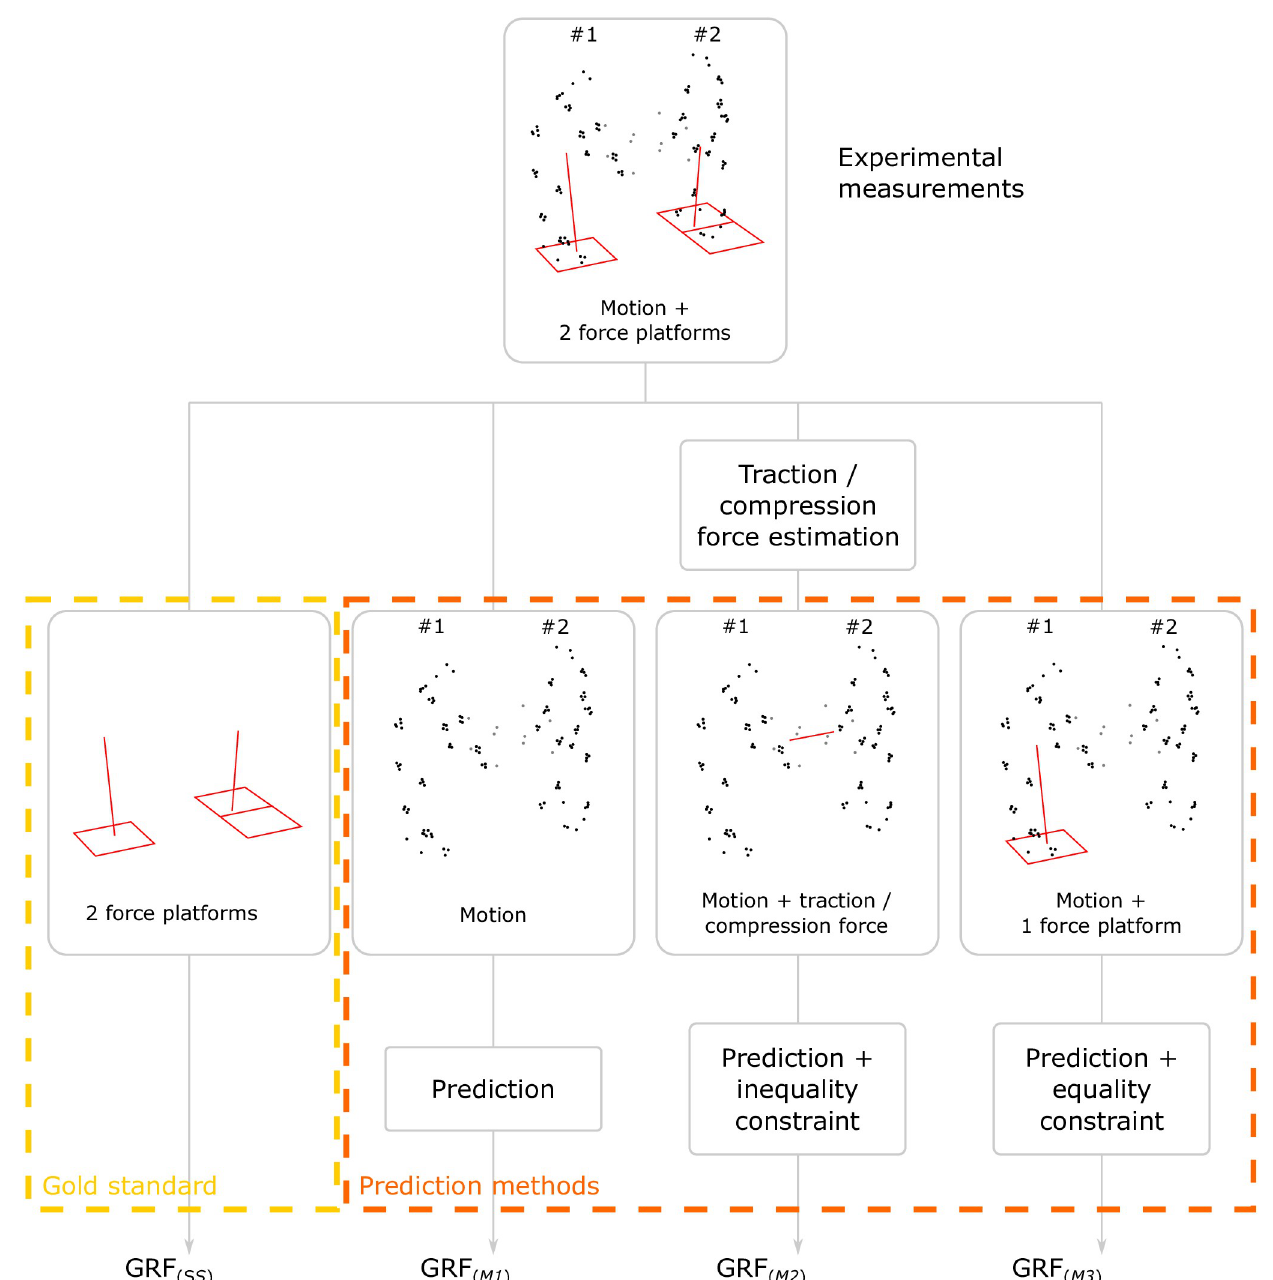
Fig 3. Setup of the gold standard ( GS ) and the three prediction methods ( M1 , M2 , and M3 ) used to estimate GRF.